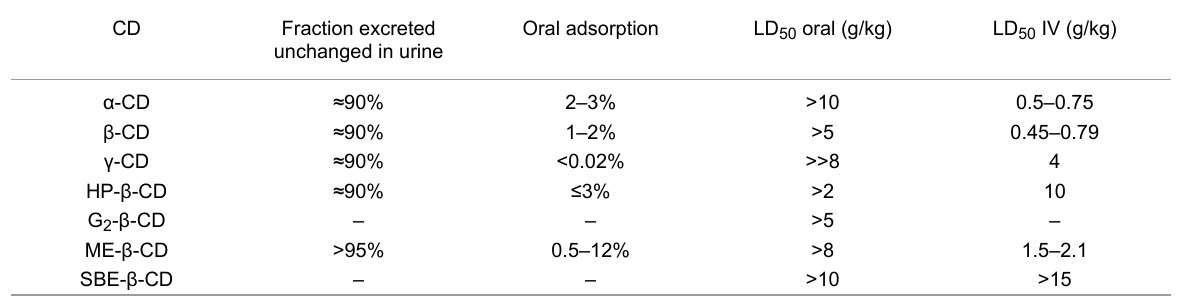
Table 3: Pharmacokinetics and safety overview of some native and modified CDs for rats.